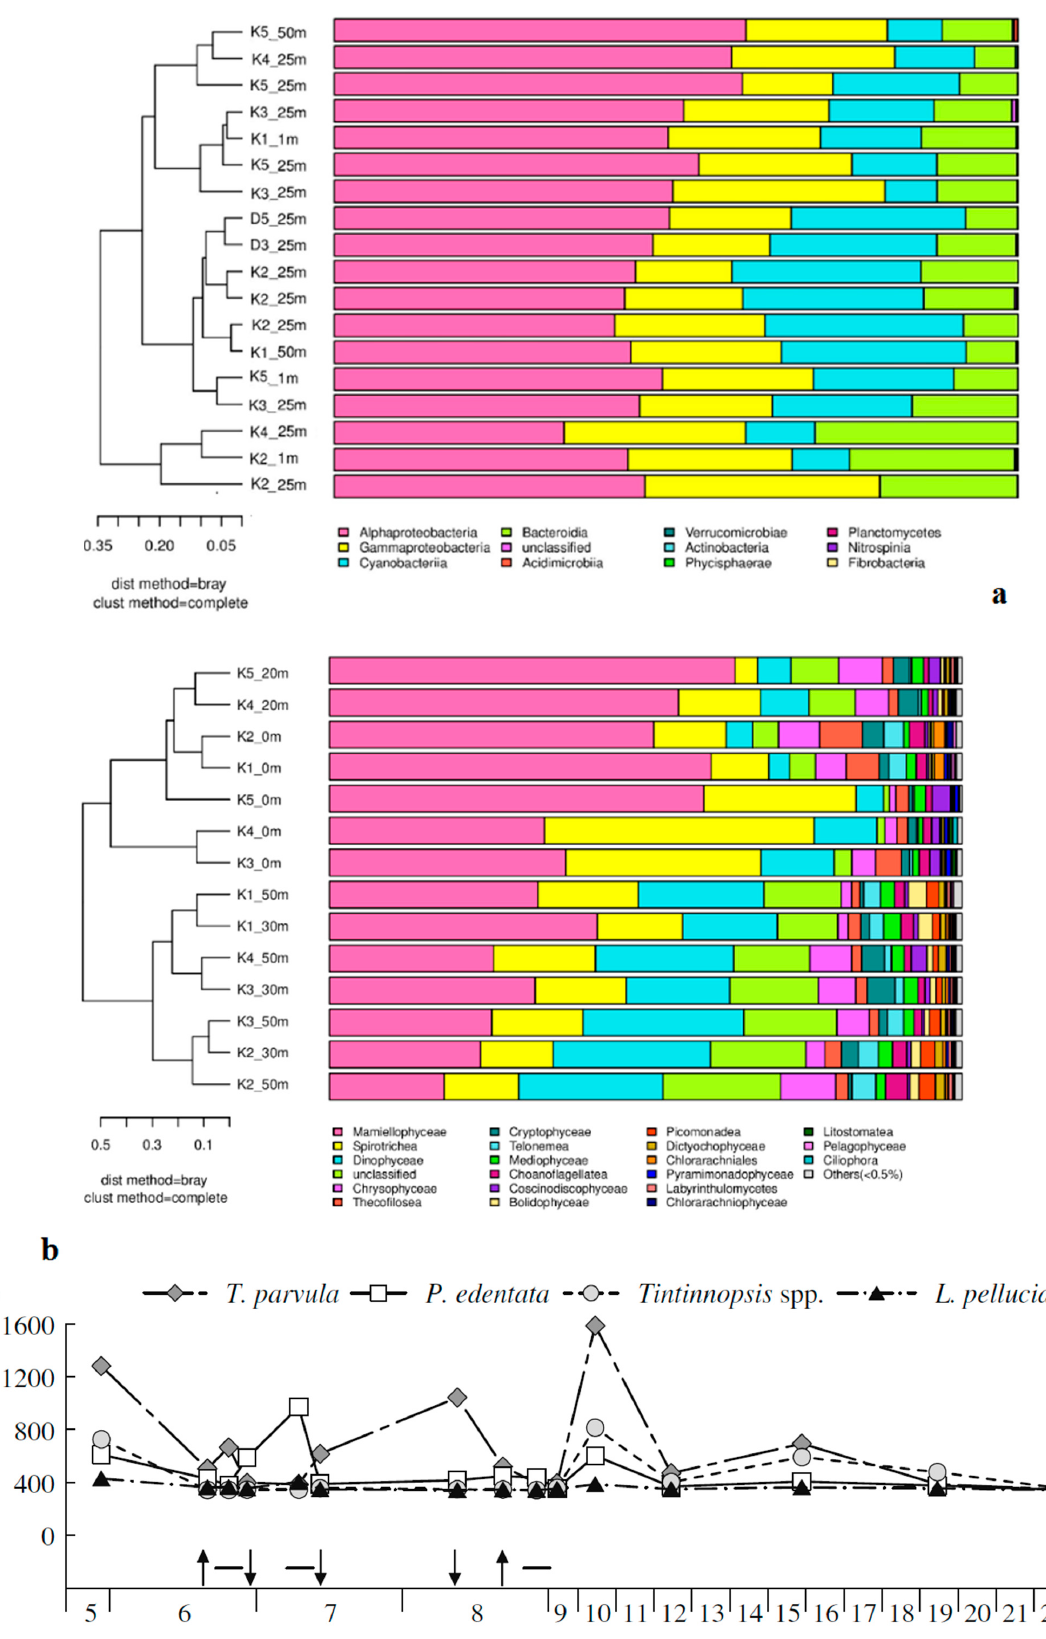
Figure 8. Distribution map of main microplankton communities in Kongsfjorden in 2012: ( a ) Prokaryotes, ( b ) Eukaryotes and ( c ) Ciliates. The arrows in Figure 8c indicate the dates on which the abundance data were collected [12,35].